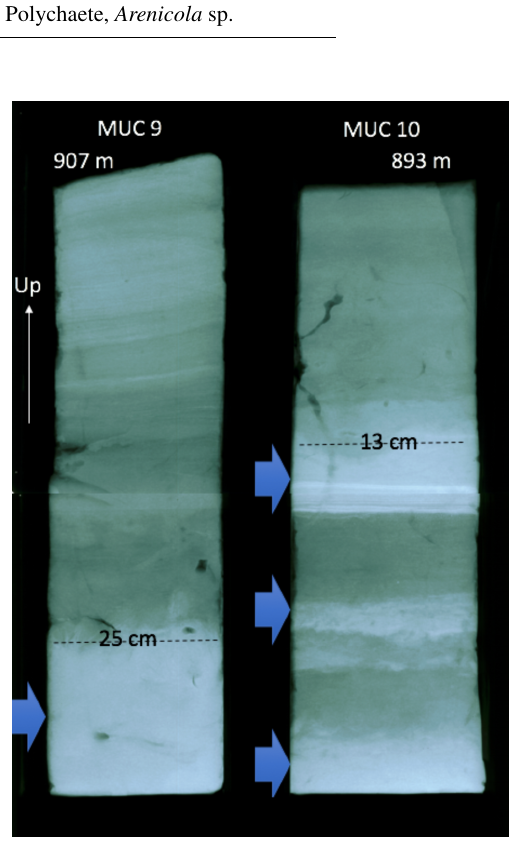
Figure 6. X-radiographs of cores MUC 9 and MUC 10. The arrows designate the location of turbidites, which show up under X-rays as more lightly colored (denser). Note the fine laminations visible in the upper portion MUC